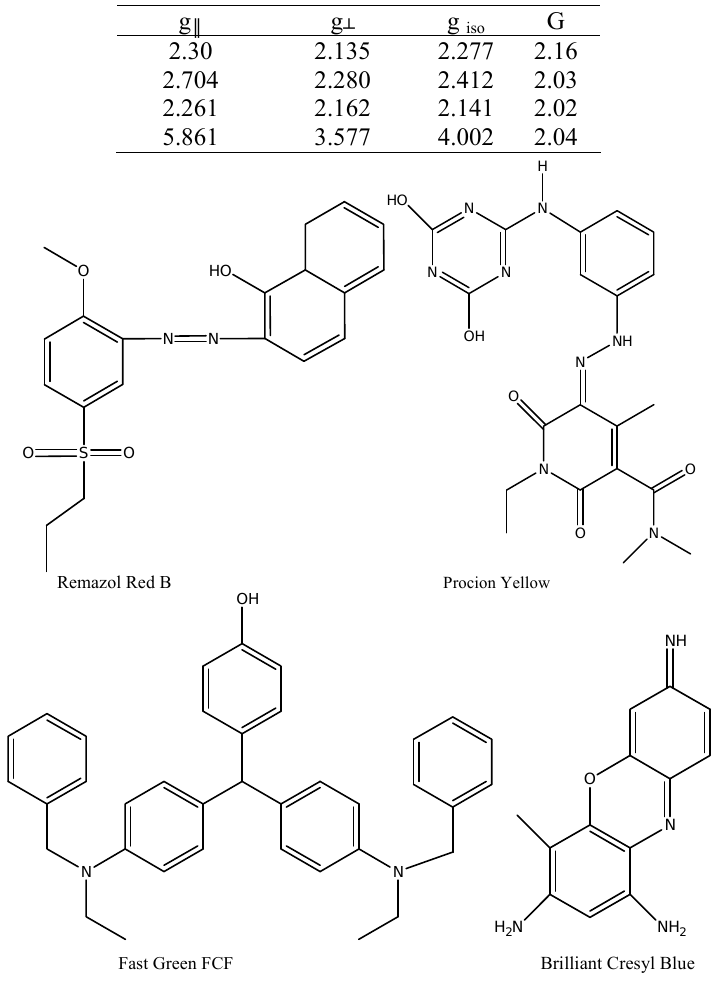
Figure 1. Chemical structure of the four dyes used in this